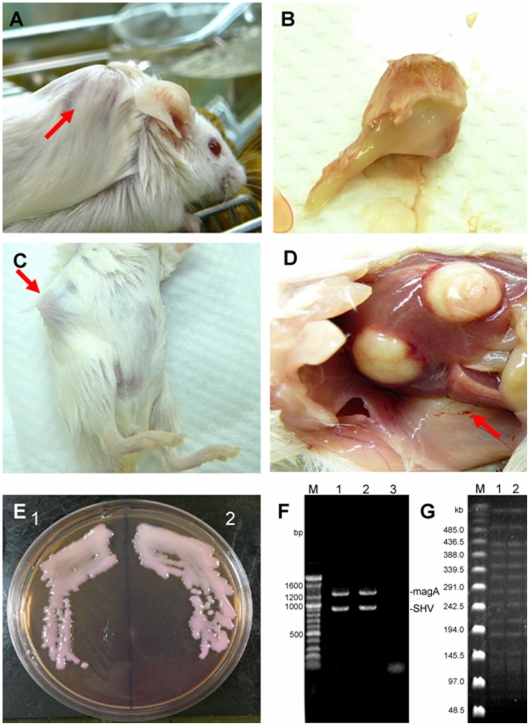
Gross abscess appearance in mice injected with neutrophils containing phagocytosed serotype K1 K. pneumoniae.A: Neck. B: Surgical removal of the abscess site. C: Abdomen. D: Abscess formation in liver and subcutaneous areas. E: (1) Morphological features of injected serotype K1 K. pneumoniae and (2) culture of pus discharge from the abscess site. F: Detection of the serotype K1 specific magA gene and intrinsic bla
SHV gene from (1) the parental strain and (2) bacteria isolated from the abscess site. G: PFGE molecular typing of (1) the parental strain and (2) bacteria isolated from the abscess site. Sites of abscess formation are indicated by red arrows.